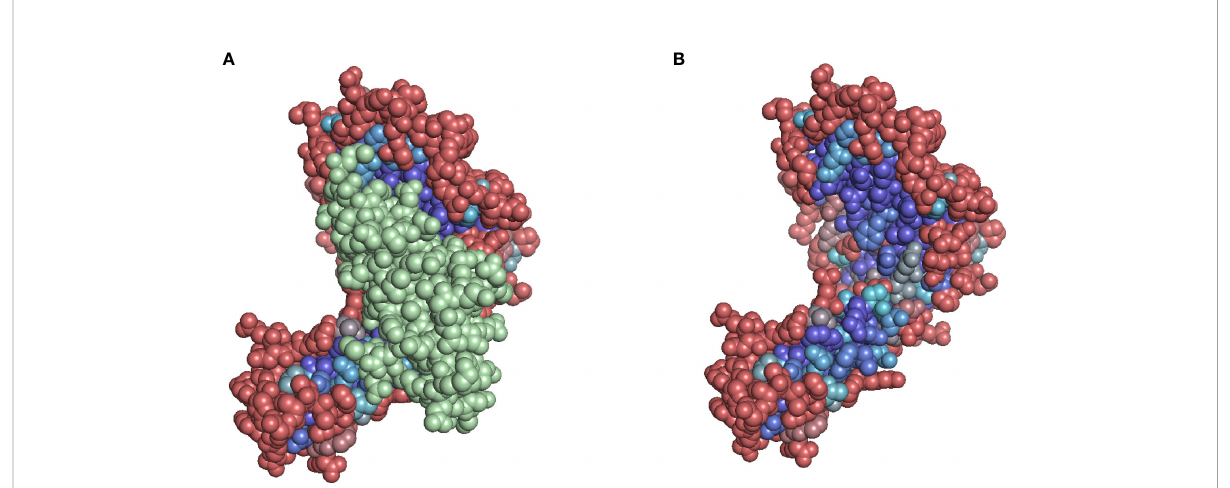
FIGURE 10 (A) Solvent accessibility-colored residues of A*02:01. Beta-2-microglobulin is colored in green. (B) Residues masked by the beta-2-microglobulin structure are predicted to be inaccessible. Color (gradient from red to purple to blue) based on Snow fl ake score, red tones indicating higher solvent accessibility, blue tones indicate lower solvent accessibility.